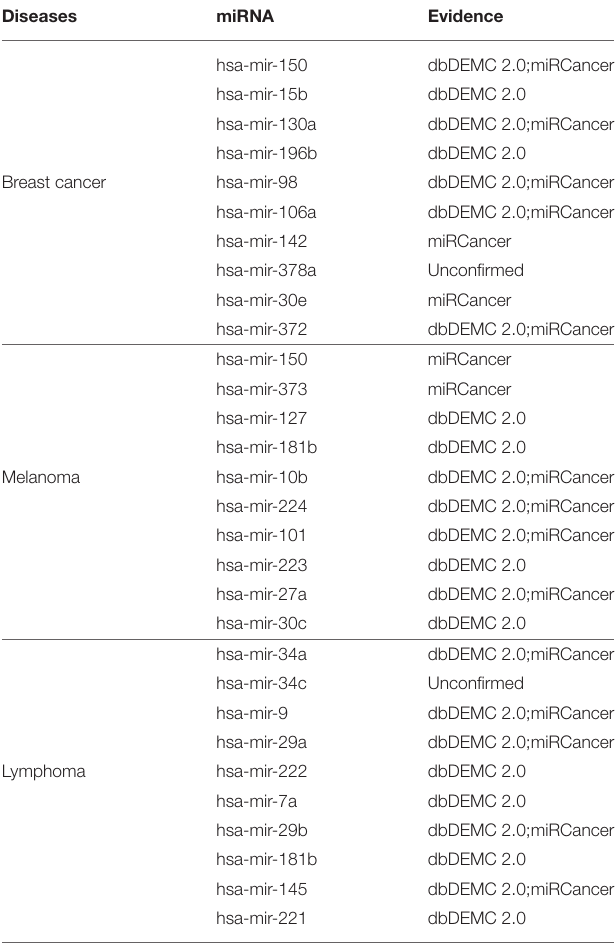
TABLE 5 | The candidate miRNAs associated with breast cancer, melanoma, and